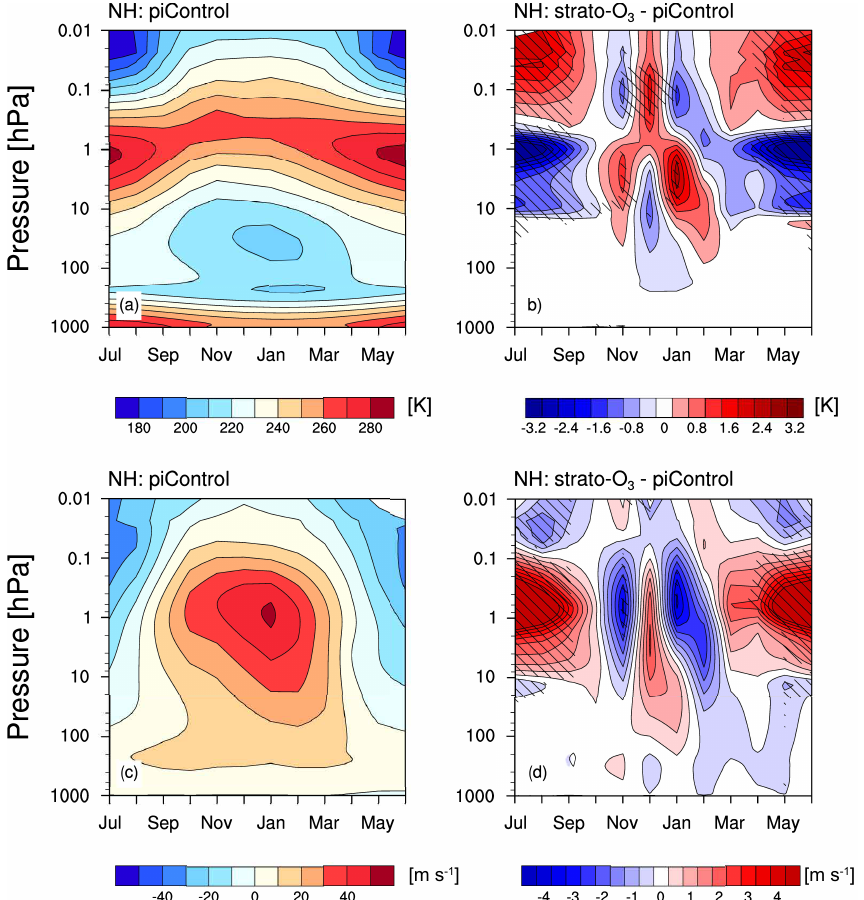
Figure 3. Monthly mean temperature (top row) averaged between 60 and 90 ◦ N (K) and zonal wind (ms − 1 ; bottom row) for 60 ◦ N for (a, c) piControl and (b, d) the difference between strato-O 3 and piControl. Shaded areas are statistically significant at the 95% con- fidence